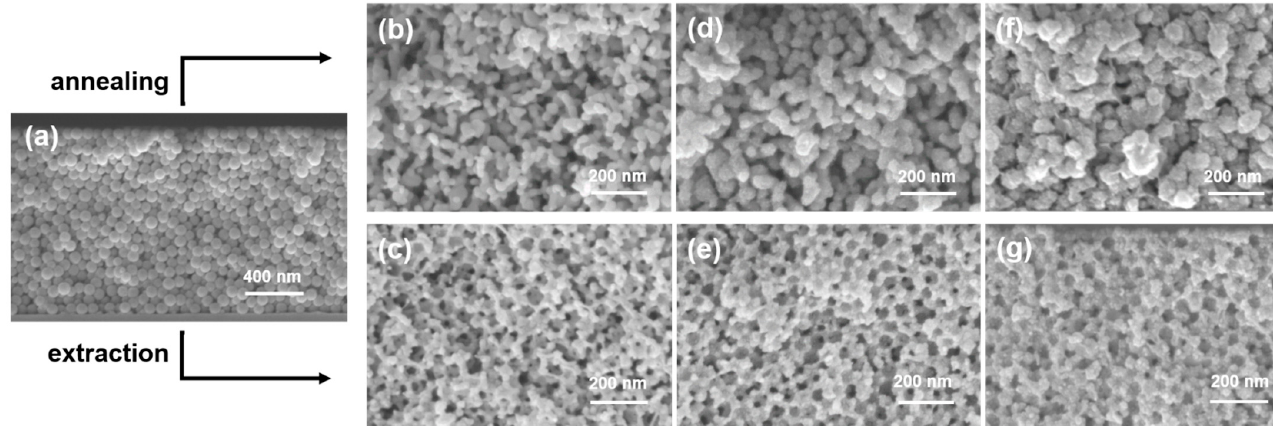
Figure 4. Cross-section SEM images of ( a ) PS particles with diameter 70 nm assembled in colloidal crystal thin film, ( b ) monomodal ZnO IO, obtained by mineralization of ( a ) with three ZnO deposition cycles and calcinated at 500 °C for 3 h, ( c ) monomodal ZnO IO obtained by mineralization of ( a ) with three ZnO deposition cycles and extraction of PS particles with toluene at 60 °C, ( d ) and ( e ) ZnO IOs from ( b ) and ( c ) further mineralized with one ZnO deposition cycle, respectively. ( f ) and ( g ) ZnO IOs from ( b ) and ( c ) further mineralized with two ZnO deposition cycles, respectively.